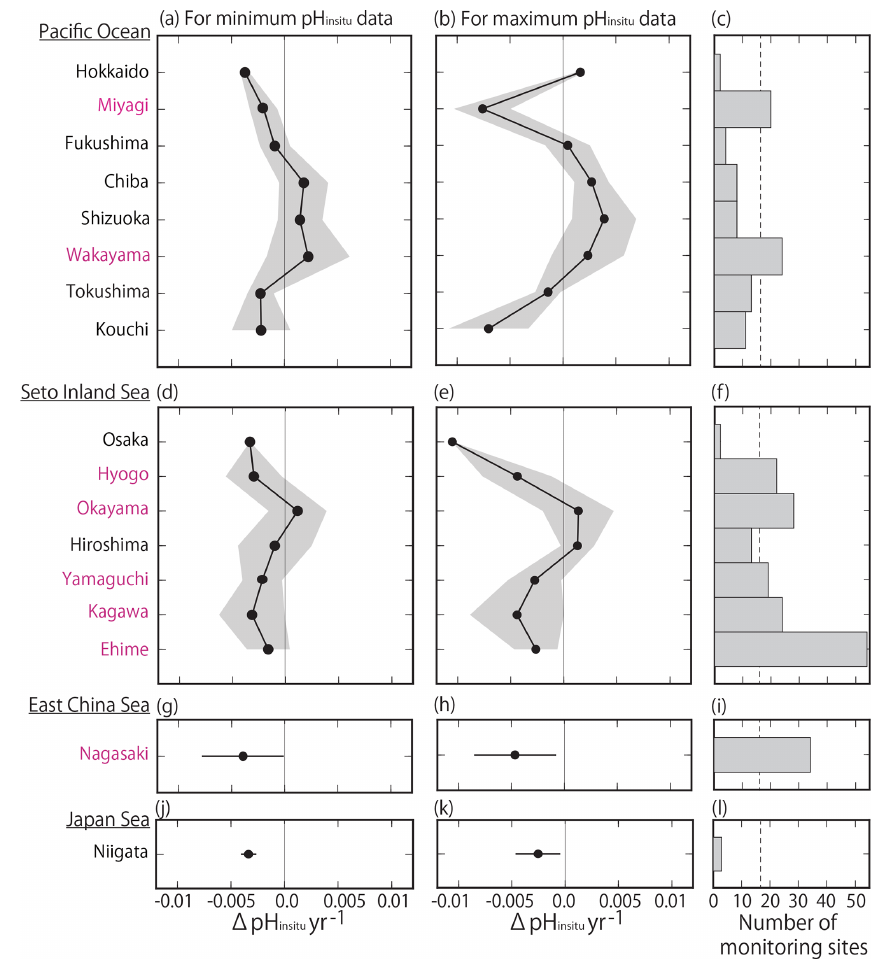
Figure 9. (a, b, d, e, g, h) Average minimum and maximum pH insitu trends ( (cid:49) pH insitu yr − 1 ) in each prefecture. These panels show each side of the Pacific Ocean (a, b) , the Seto Inland Sea (d, e) , the East China Sea (g, h) , and the Sea of Japan (j, k) . The prefecture names are arranged vertically from eastern (northern) to western (southern) areas. Black shading indicates a single standard deviation from the average. (c, f, i, l) Number of monitoring sites in each prefecture, and the thin dashed line is the threshold value of 17 (i.e., the average number of monitoring sites in all prefectures). The prefectures that meet the threshold are indicated in pink. This figure is based on the results shown in Figs. 7e and f and